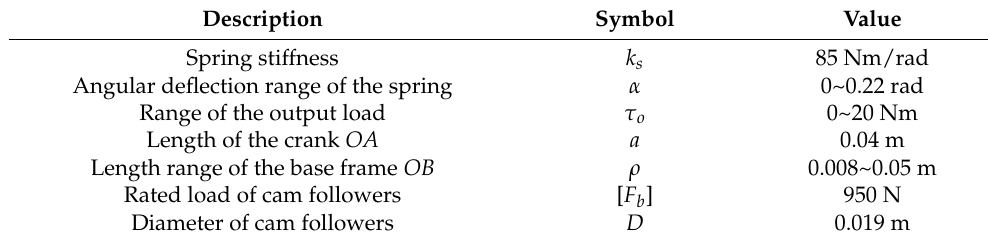
Table 1. Specifications of the variable stiffness module.